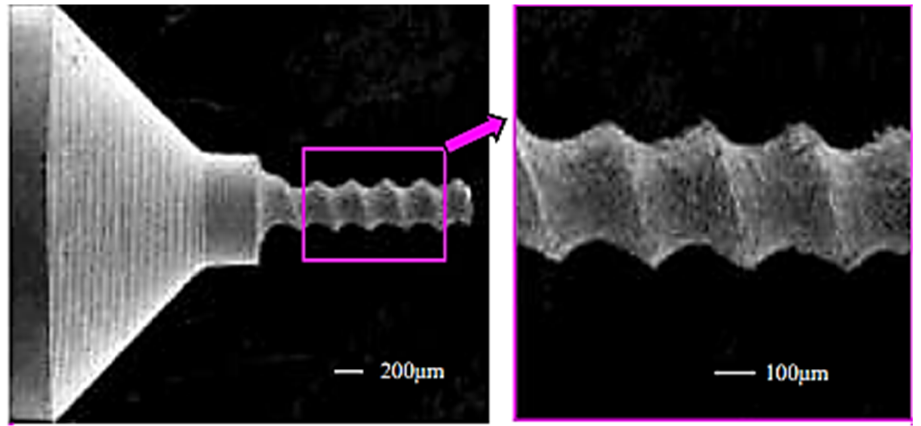
Figure 11. SEM images of spirals microelectrode fabricated by LS-WTET process (Reprinted/Adapted with permission from [59]. 2018, Elsevier. ©).